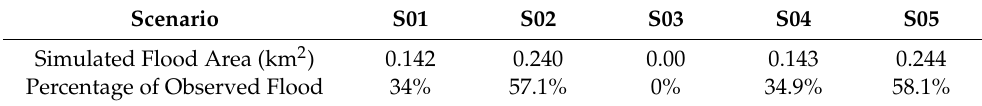
Table 5. Summary of simulated flood area for each scenario from the HEC-RAS simulation.